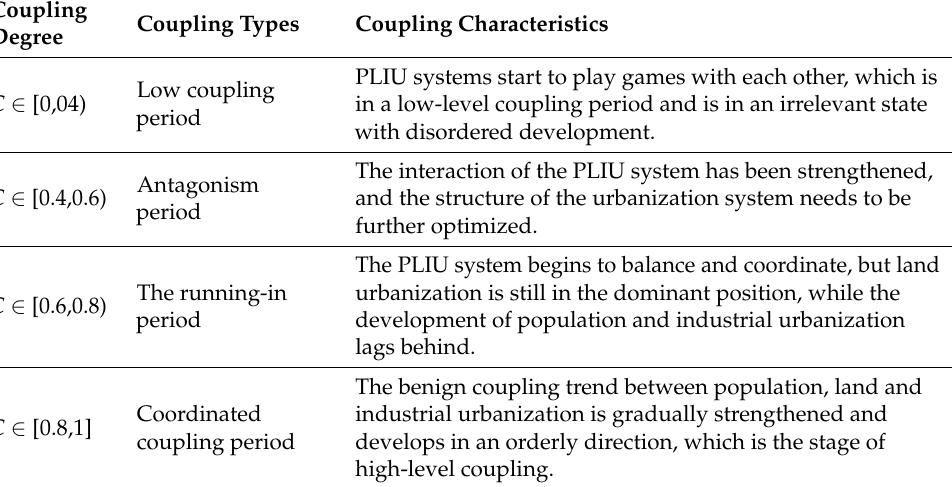
Table 1. Classification of PLIU coupling